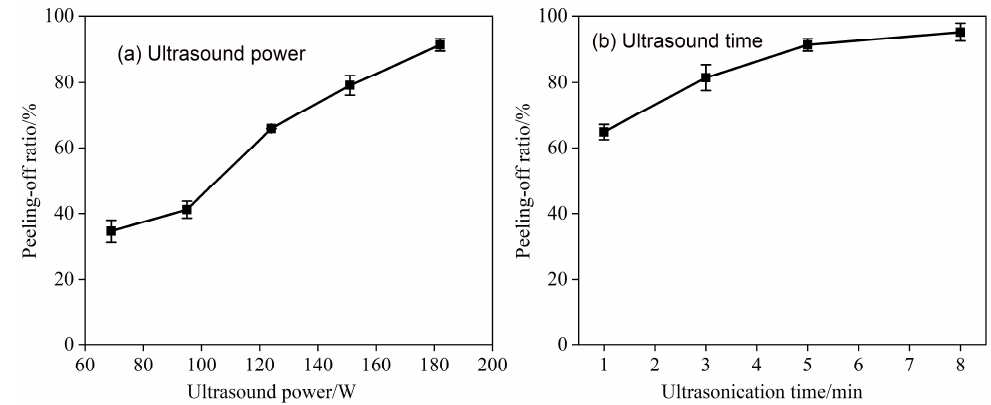
Figure 5. Effects of ultrasound power (( a ) 5-min ultrasonication time) ultrasonication time (( b ) 182 W ultrasound power) on peeling-off ratios of graphite.